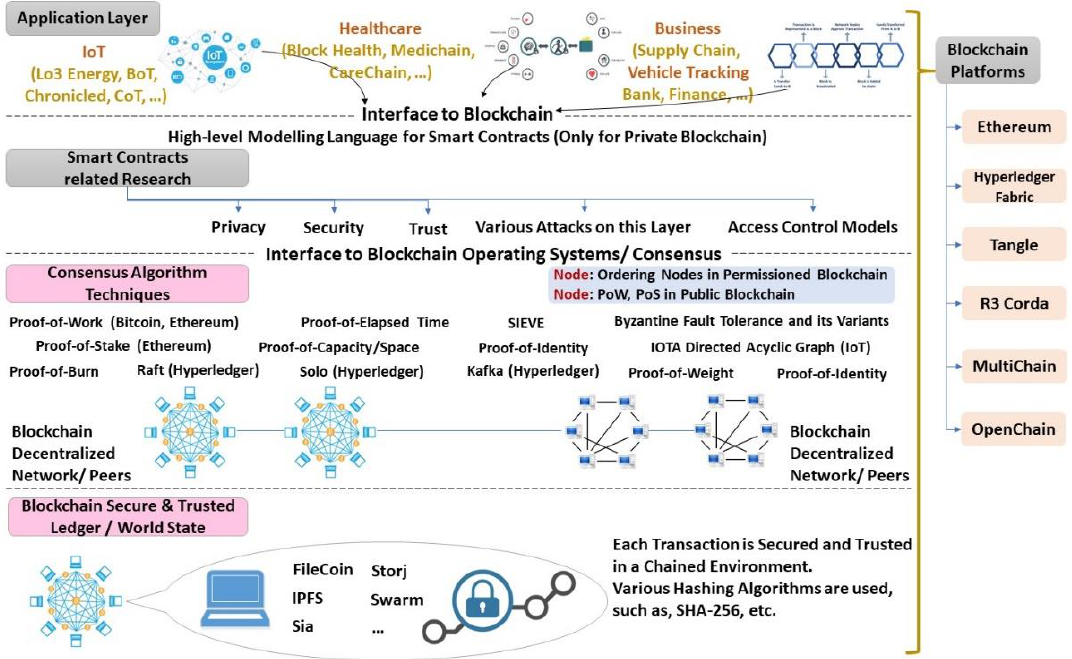
Figure 1. Working of the blockchain (by same author [14]).